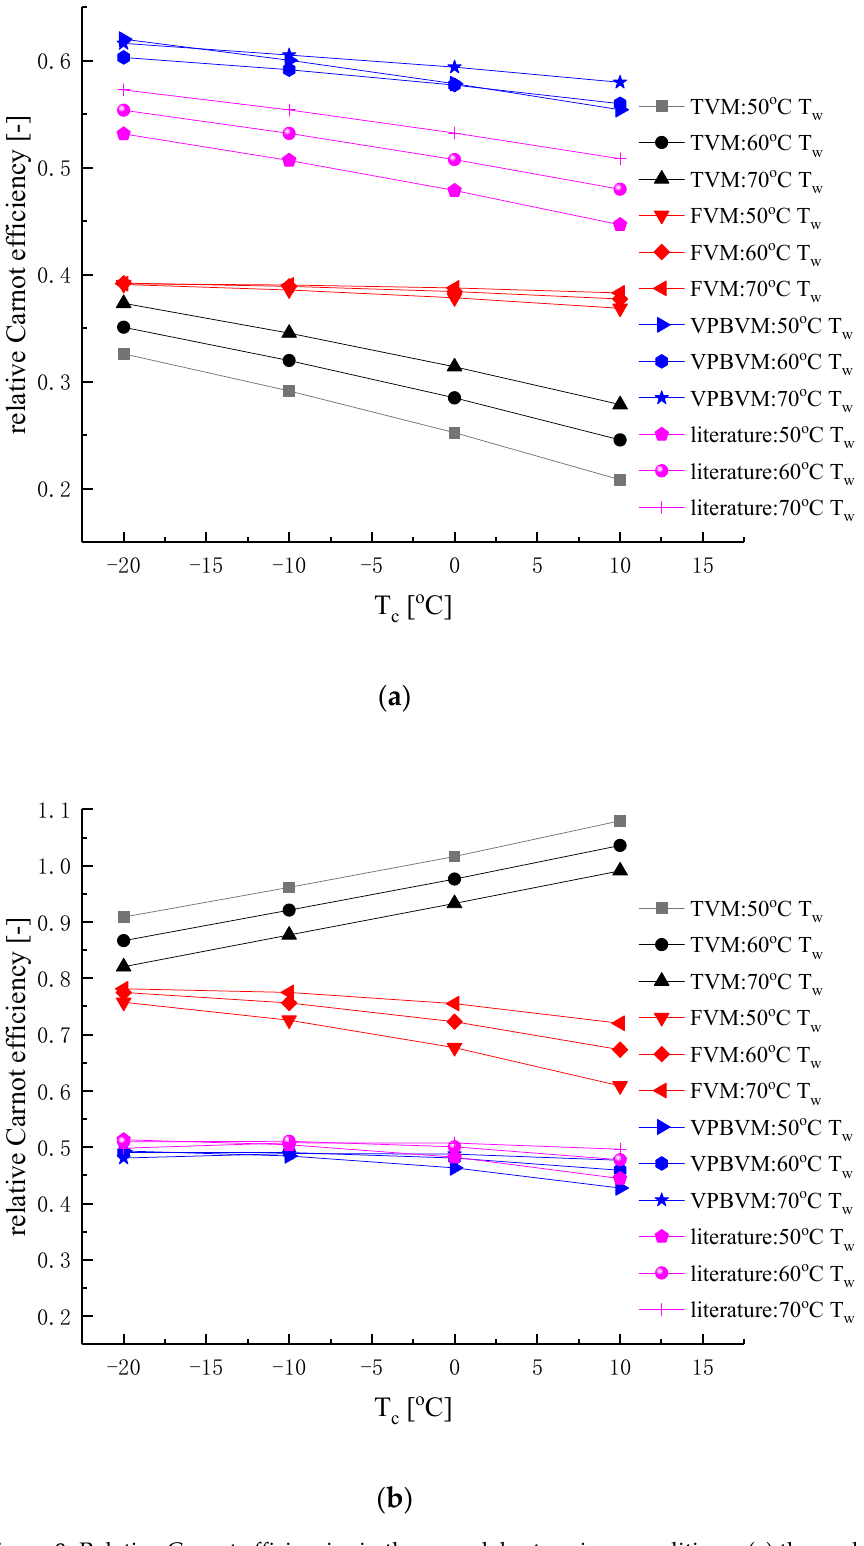
Figure 8. Relative Carnot efficiencies in three models at various conditions: ( a ) thermal efficiency; ( b ) COP C